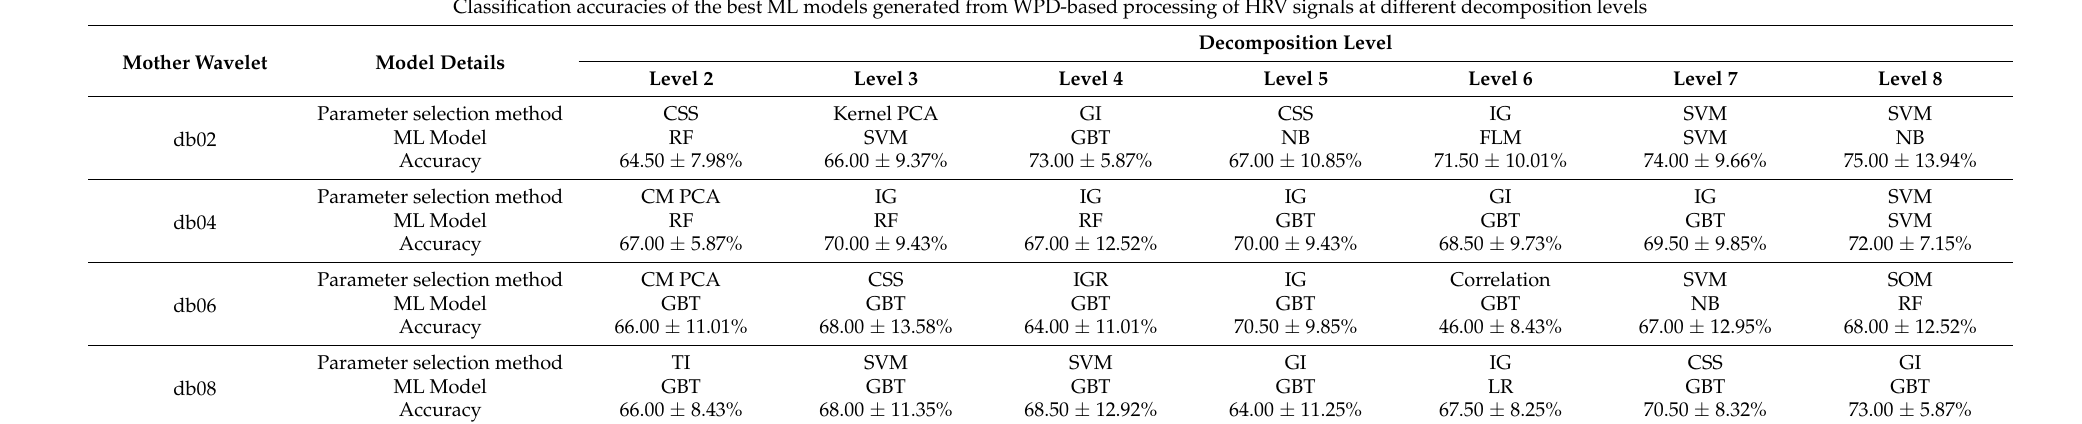
Table 6. Classification and AUC accuracies of the best ML models generated from WPD-based processing of HRV signals at different decomposition levels.